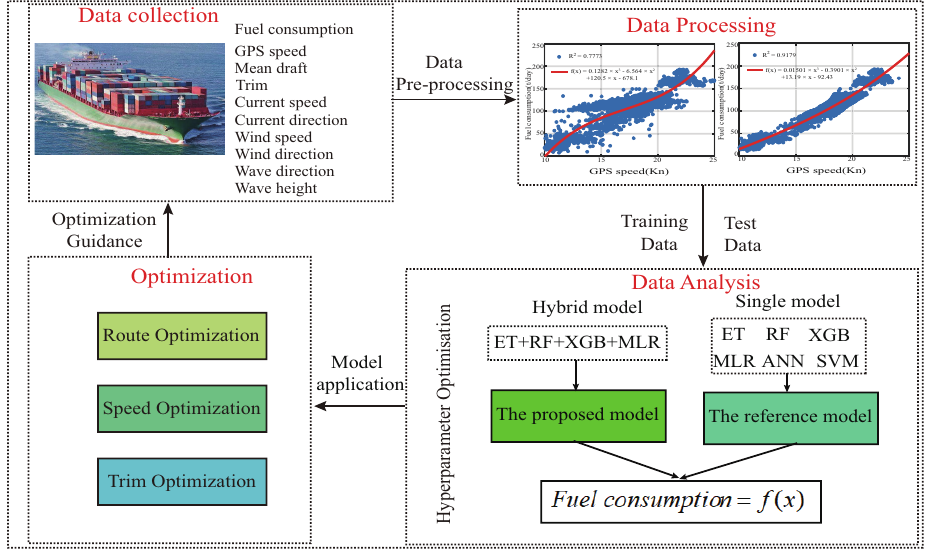
Figure 3. Research structure